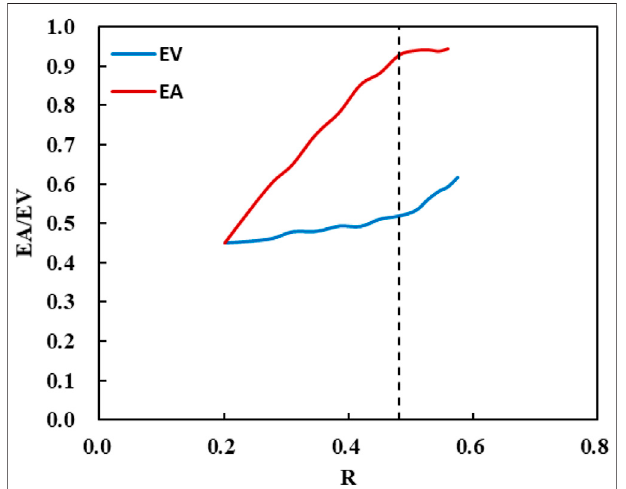
FIGURE 5 | The relation curve of sweep ef fi ciency and oil displacement ef fi ciency with the recovery of reservoir.